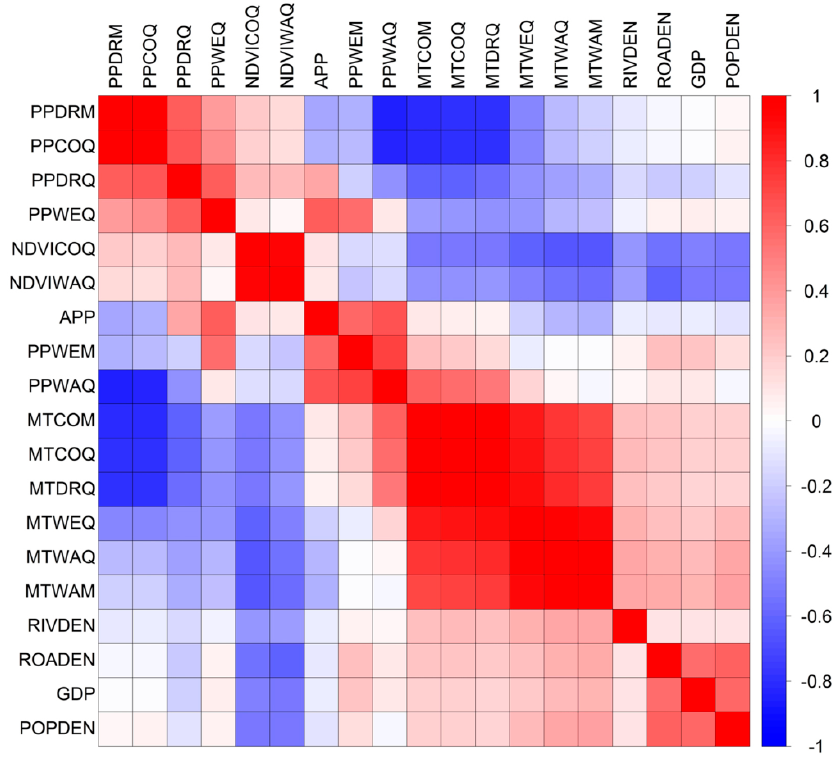
Figure 2. Matrix of correlations between all pairs of original variables. Table 3. Description of models integrating various types of variables.